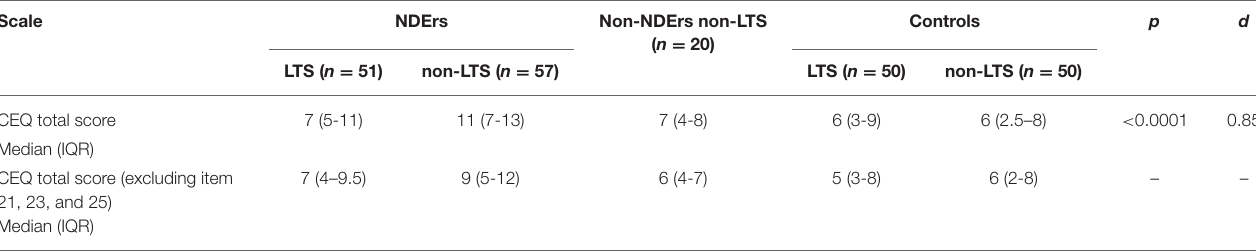
TABLE 2 | CEQ total scores of subsamples (on the first line: total scores summing all items; on the second line: total scores excluding the three items overlapping with the Greyson NDE scale items).